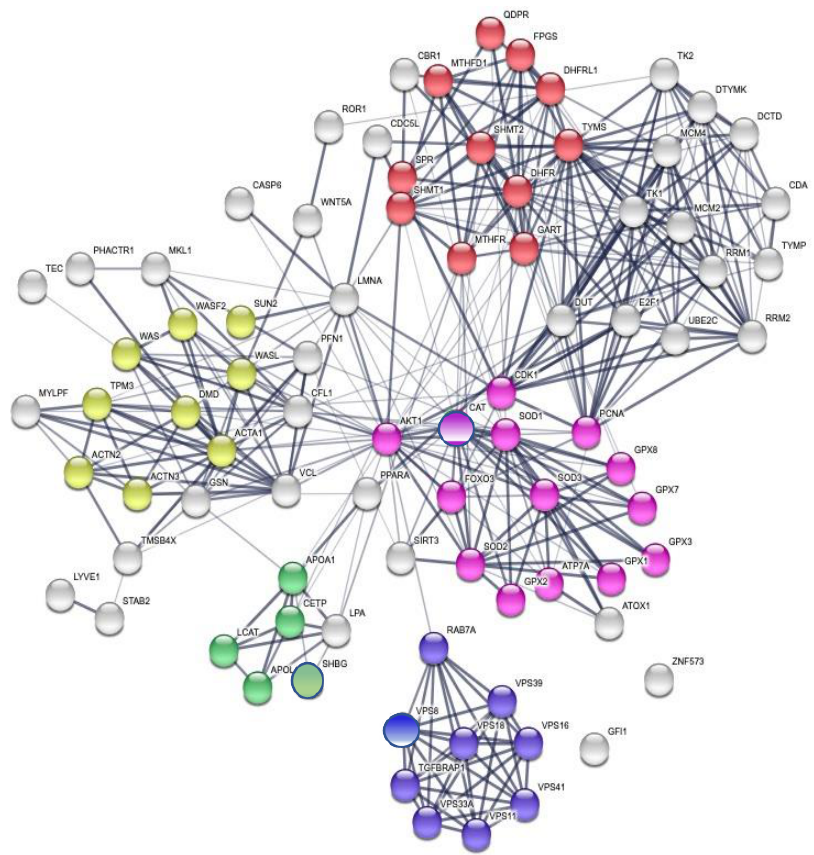
Figure 4. Global network visualization based on the STRING pathway enrichment analysis of the 14 selected proteins (12 + TYMS or TS and DHFR). The network shows the most relevant biological process containing the protein panel. Details are reported in the main text. The STRING features are the following: yellow spheres, actin-filament based movement and regulation (GO:0030048, FDR 1.31 × 10 −7 , 9/105); green spheres, cholesterol metabolic process (GO:FDR 2.3 × 10 −3 ); violet spheres, endosome to lysosome transport (GO:0008333, FDR 1.78 × 10 −8 , 8/49); pink spheres, cellular response to oxidative stress (GO:0034599, FDR 5.36 × 10 −1 0 , 14/22); red spheres, pteridine-containing compounds biological process (GO:0042558, FDR 9.37 × 10 −1 4 , 11/33). A detailed GO analysis shows that